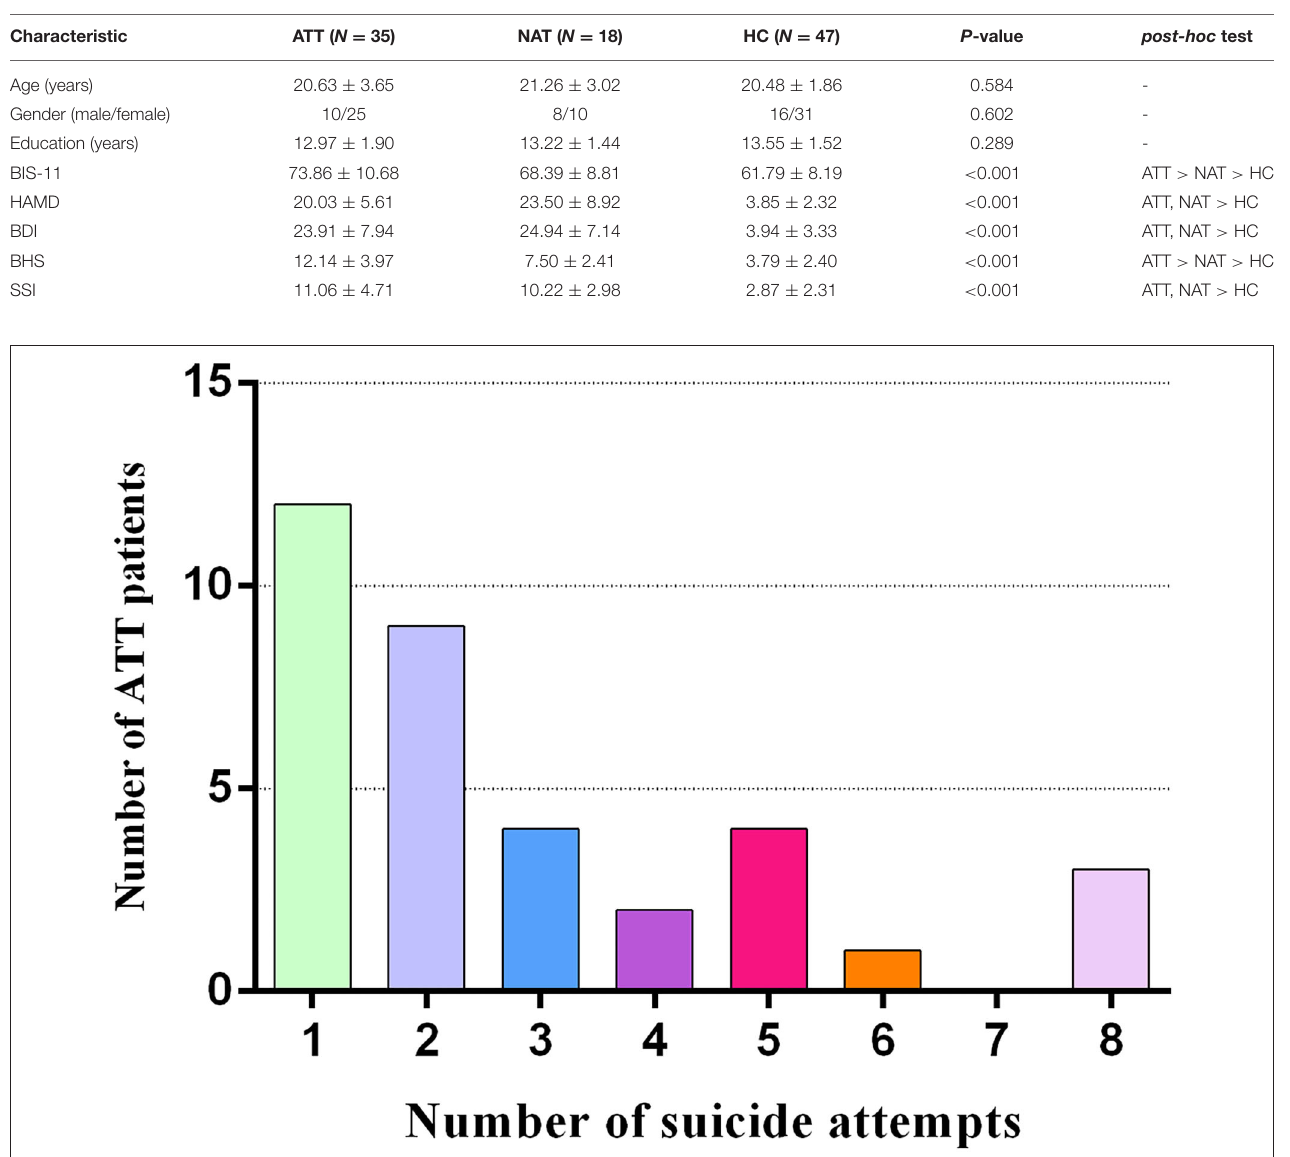
FIGURE 1 | The number of suicide attempts in 35 ATT patients (who had attempted suicide 1 to 6 months prior to the fMRI